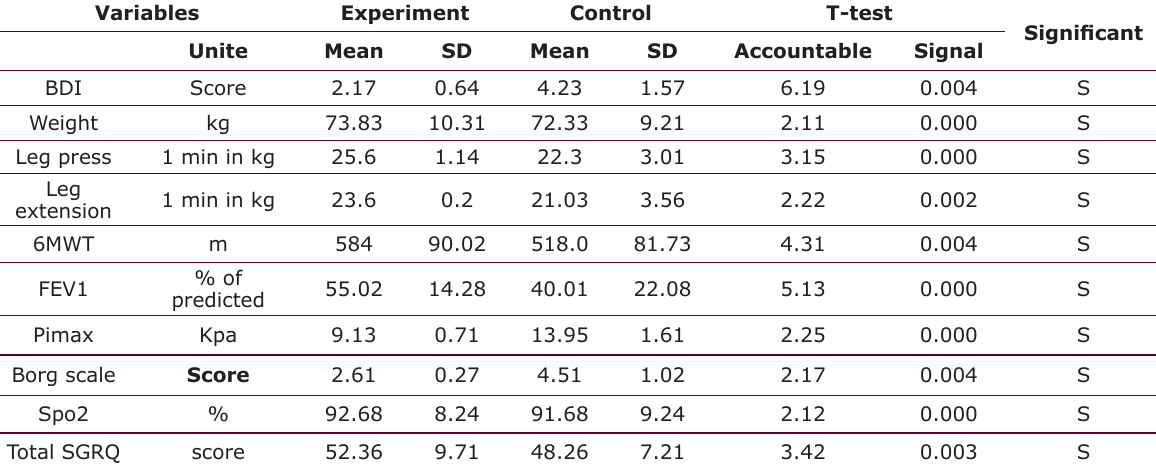
Table 6. The Mean, SD, T-test, signal, and Significant of post-tests for the experiment and control group